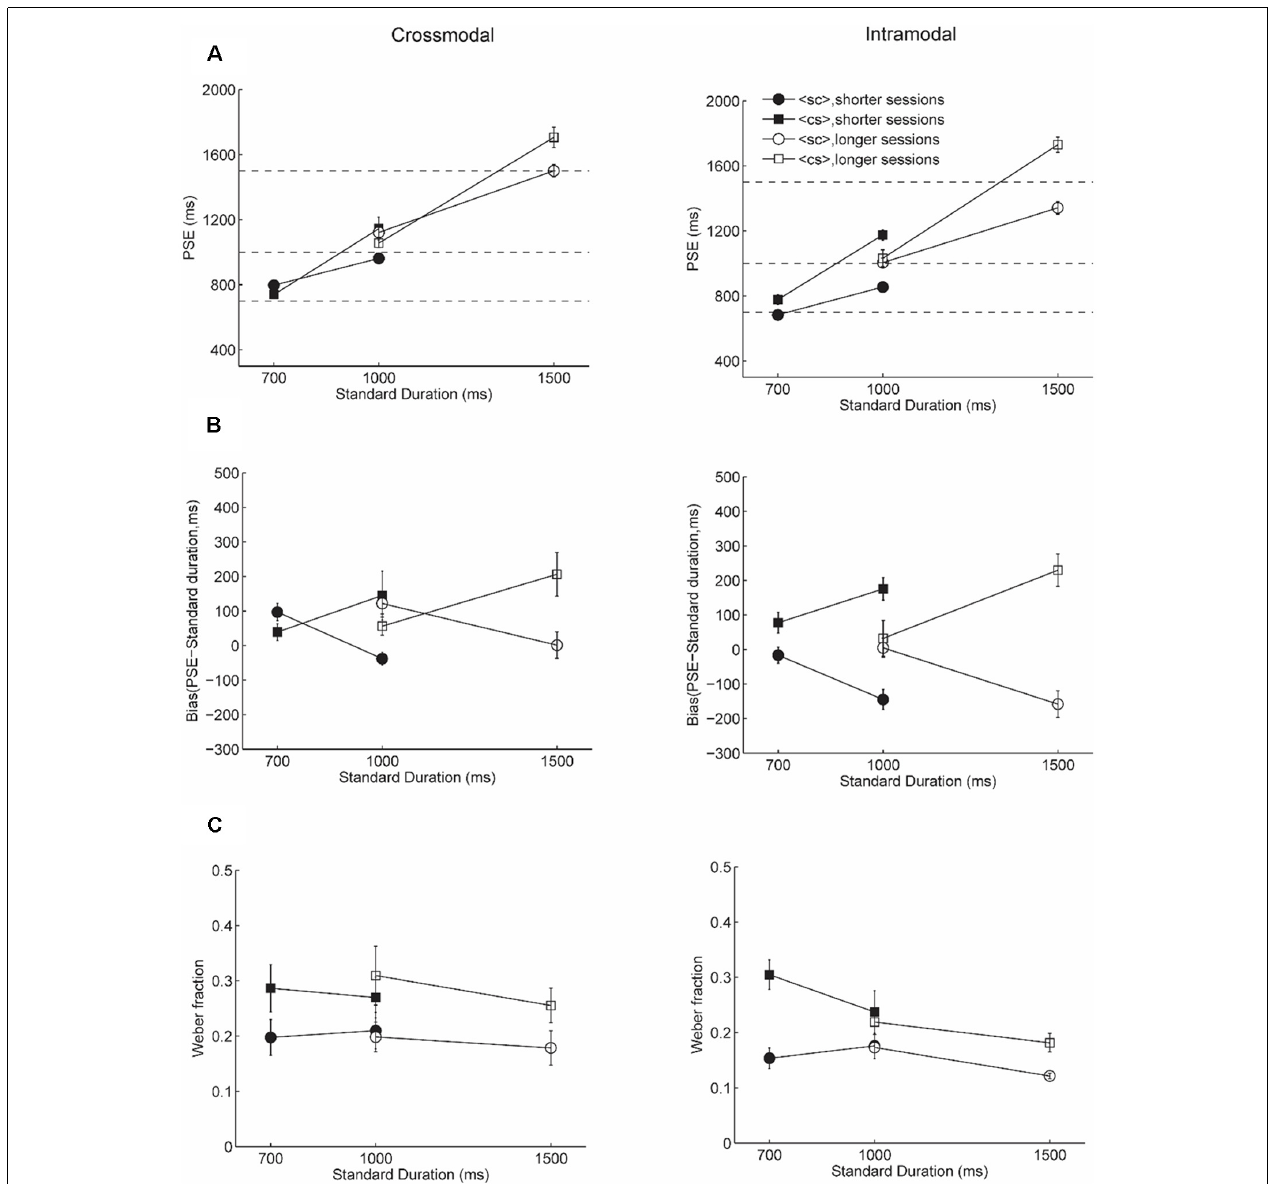
FIGURE 3 | Results of Experiment 2. Panels (A,B,C) show the PSE, bias, and Weber fraction, respectively. Left panels show results for the crossmodal condition and right panels show results for intramodal condition. Solid symbols show results for the shorter sessions and empty symbols shows results for the longer sessions. Circles show results for <sc> trials and squares show results for <cs> trials. The dashed lines in (A) show the veridical standard